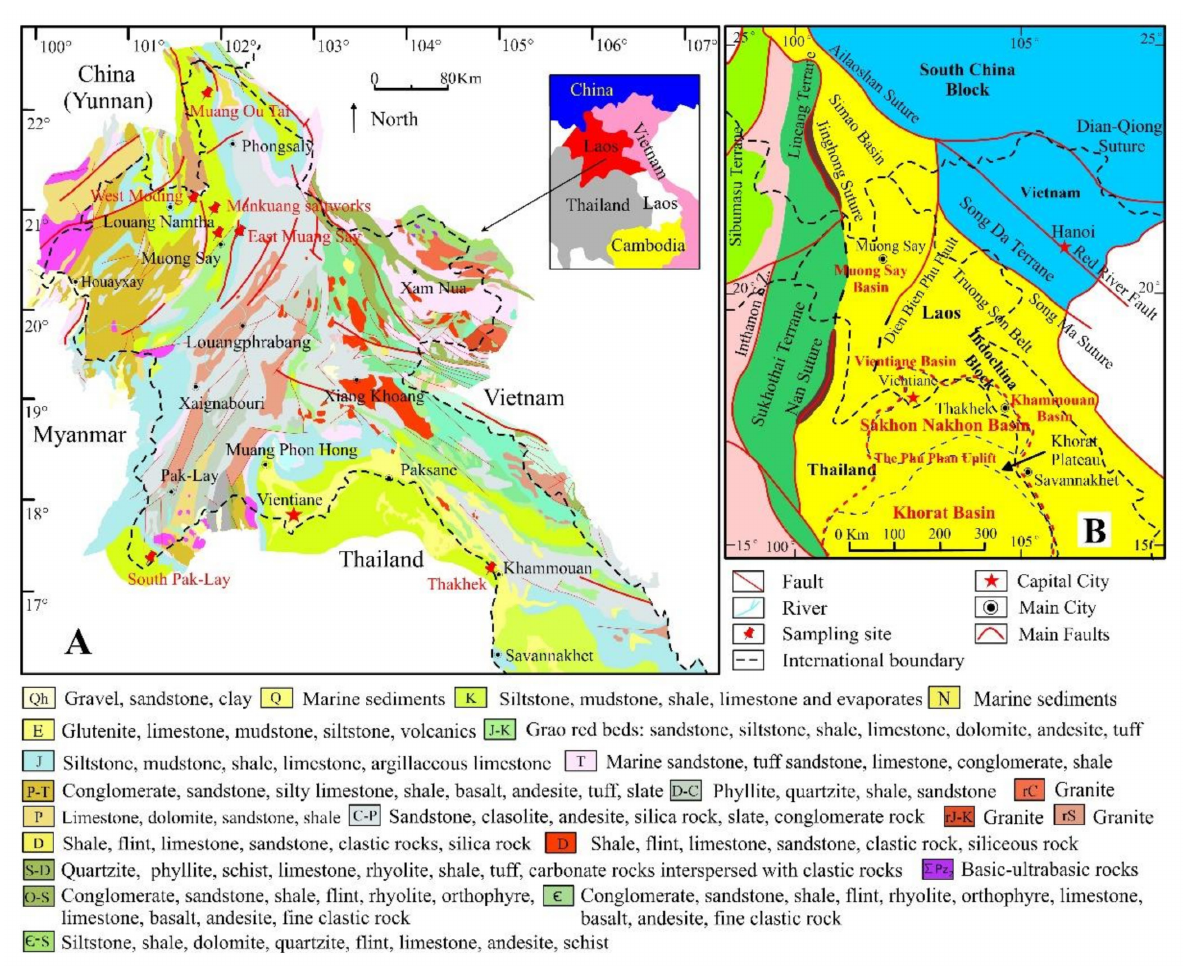
Figure 1. ( A ). Geological sketch map and sampling sites in north and central Laos (modified from Geological map of Lao People’s Democratic Republic, 1991) ( B ). Tectonic framework of central SE Asia showing the location of study area [54]. Laos is located in the northernmost part of the Indochina Peninsula. It is